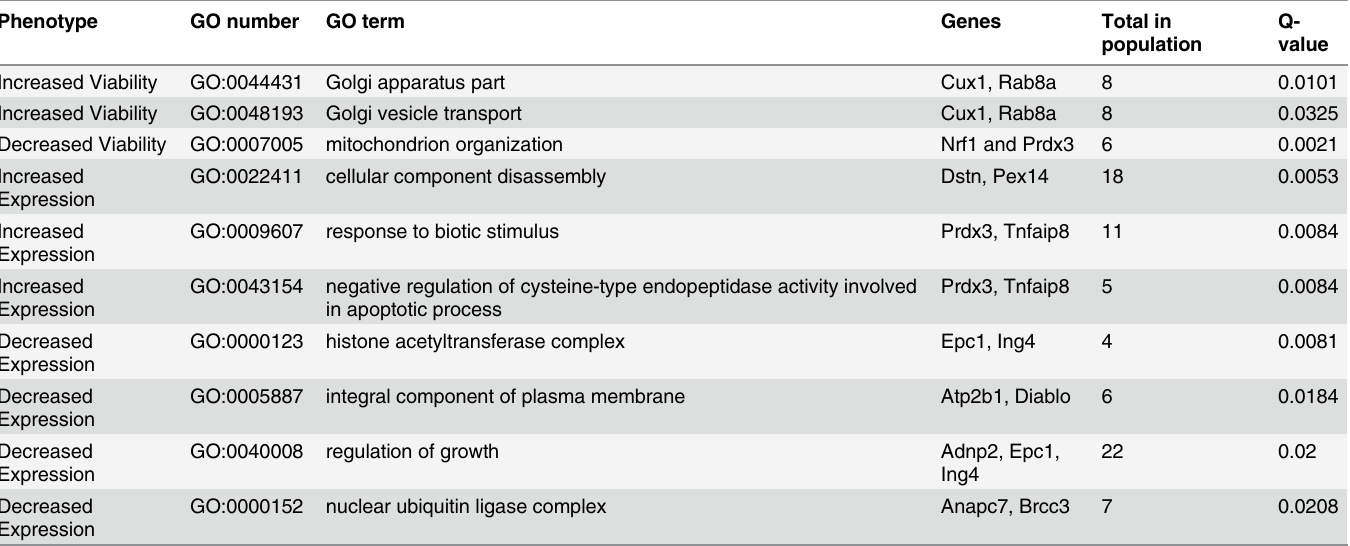
Table 3. Evaluation of hits for GO